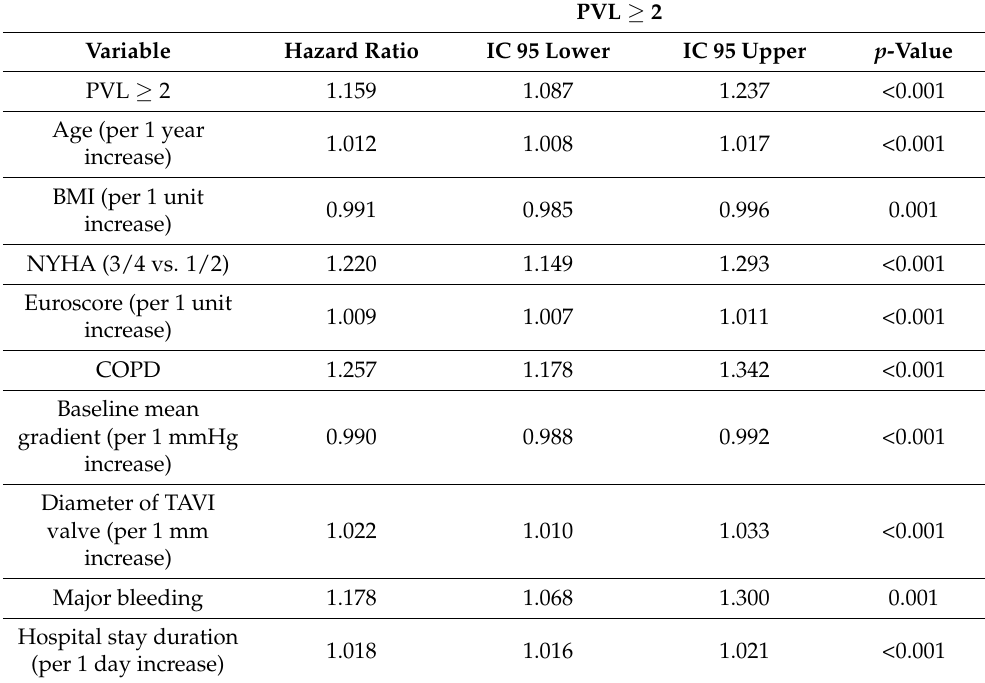
Table 6. Multivariate adjustment of predictors of all-cause mortality in PVL